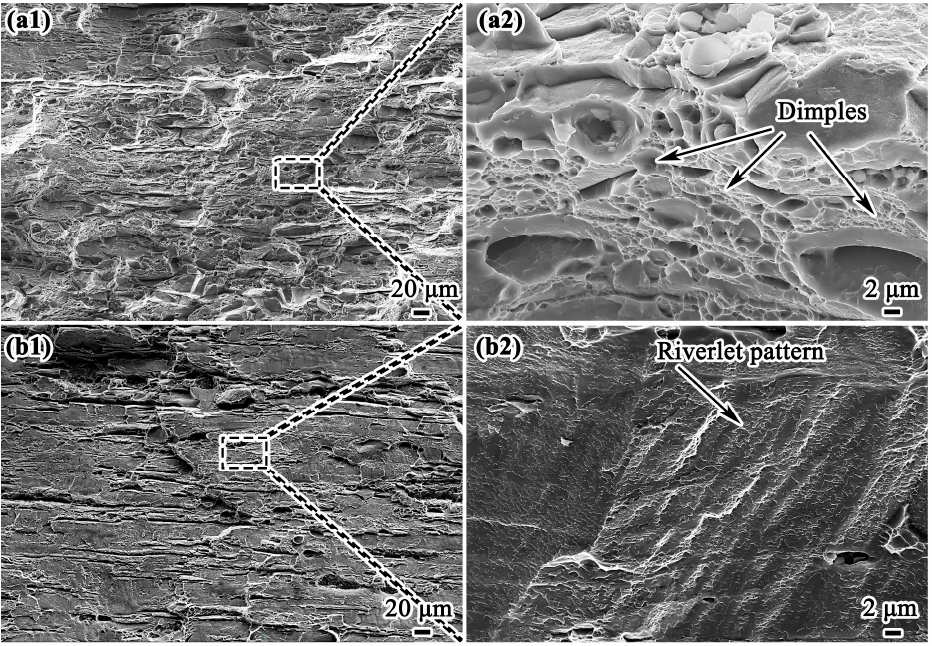
Figure 9. Fracture surfaces of the failed T6 specimens: ( a1 , a2 ) MSR 1 ; ( b1 , b2 ) CHR.